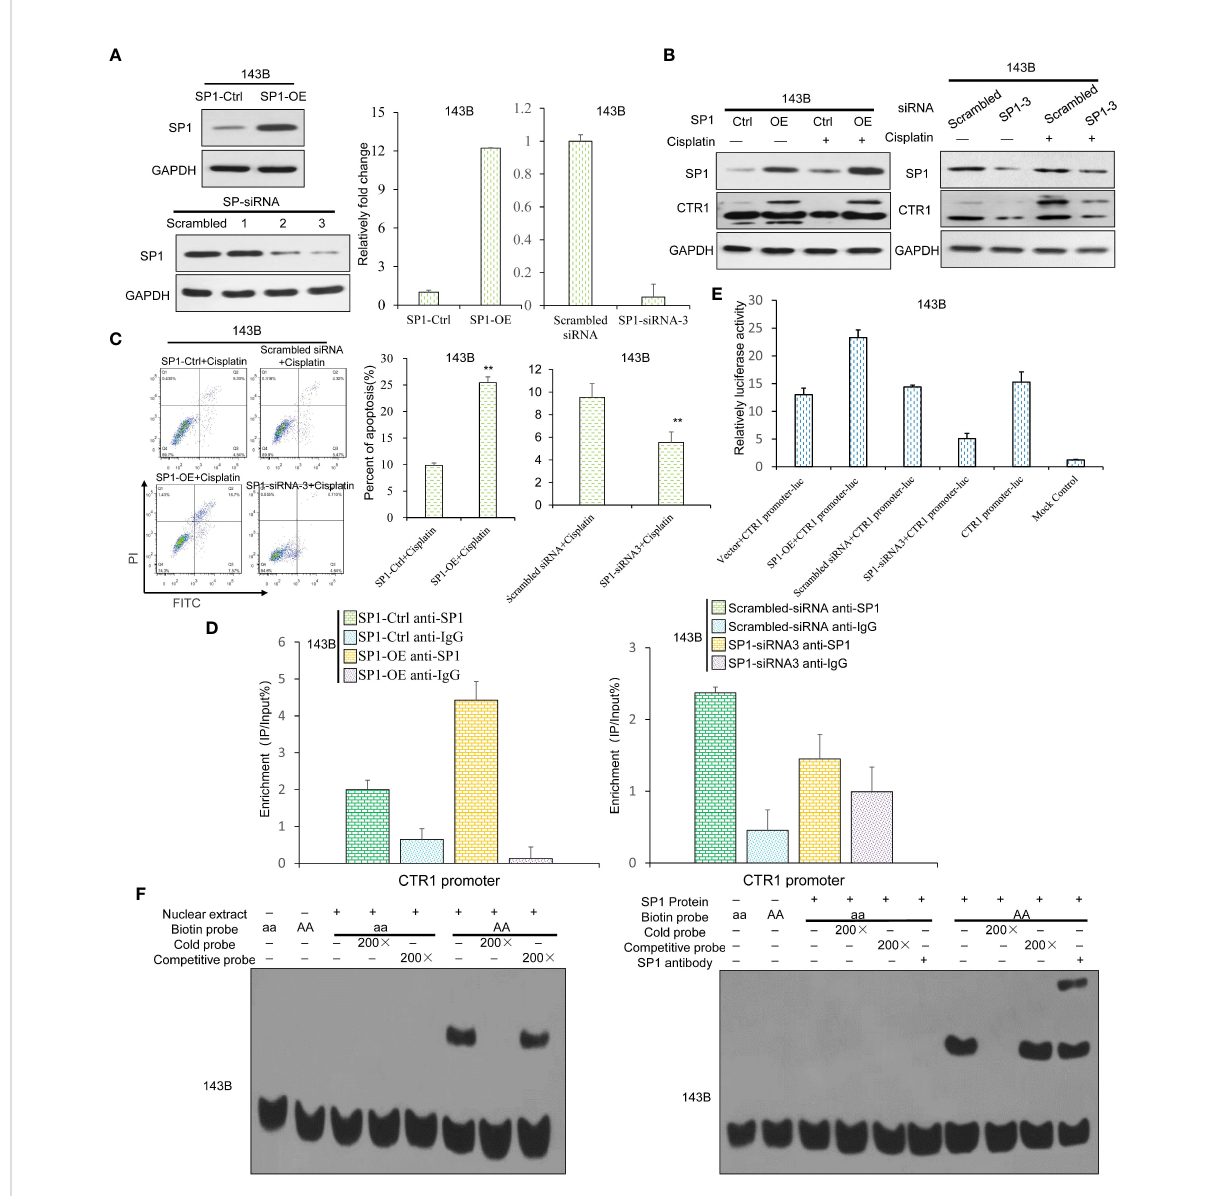
FIGURE 5 SP1 directly binds to CTR1 promoter and activates CTR1 transcription in OS cells. (A) The SP1 over-expression (SP1-OE) and knock-down (SP1- KD) 143B OS cell lines were established by transfection of SP1-OE plasmid or indicated siRNAs. SP1 mRNA and protein levels were con fi rmed by western blot and RT-qPCR. (B) The expression level of CTR1 in SP1-OE and SP1-KD 143B cells after cisplatin treatment were detected using western blot. (C) Cell apoptosis rate was measured in different SP1-expressing 143B cells with cisplatin incubation. Data are representative of three independent experiments. (D) Chromatin immunoprecipitation assay was performed, and the binding ability of SP1 protein to the CTR1 promoter was measured with ChIP-qPCR. (E) The binding ability of SP1 was detected via luciferase activity upon cisplatin stimulation. The pGL3- Basic vector showed no activity when stimulated with cisplatin. (F) The binding activity of SP1 on the CTR1 promoter was determined by EMSA assay in 143B cells. The activity of the wild-type CTR1 promoter and the mutant was tested with an EMSA assay. Bars show mean ± SD. Ctrl, the control group; **p <